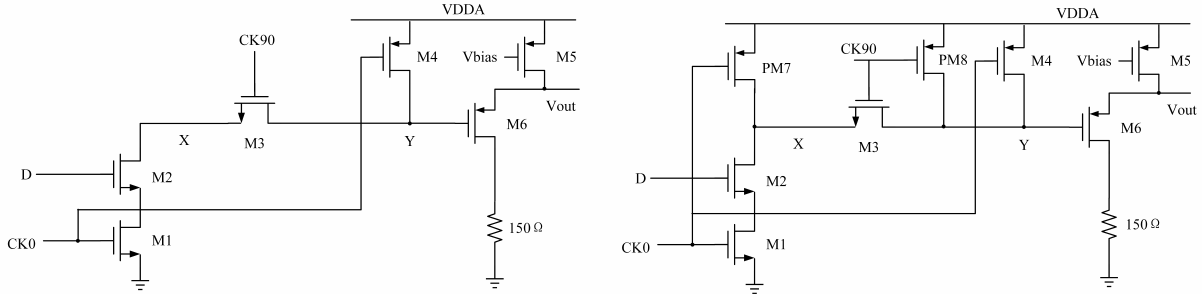
Figure 8. Pulse generation unit: ( left ) conventional structure; ( right ) structure designed in this